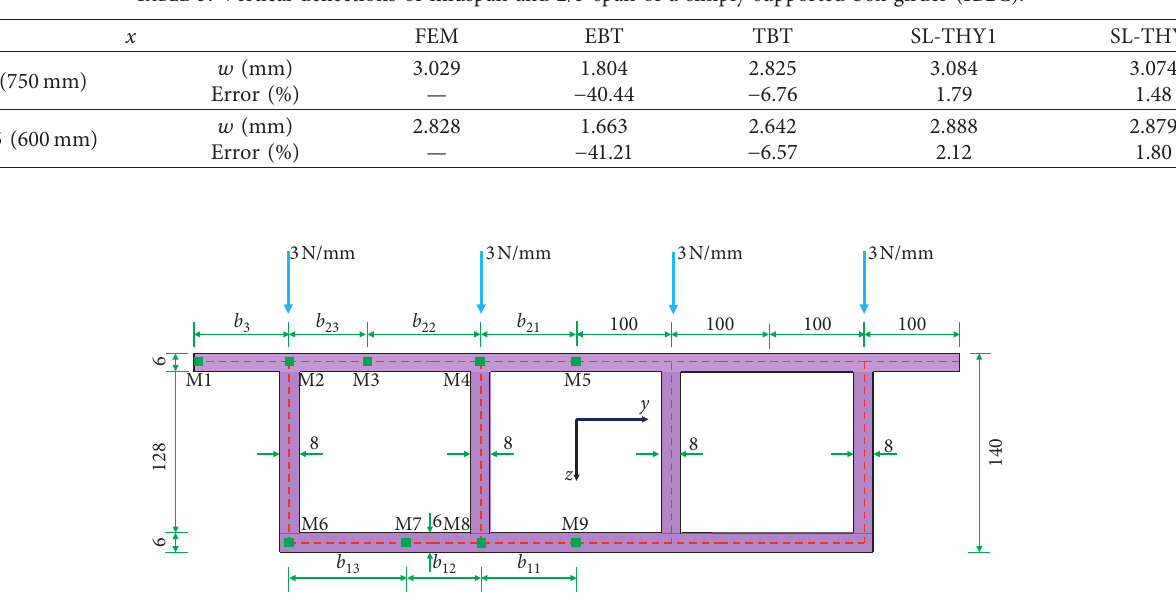
Figure 13: Cross section of the single-box three-cell box girder (unit: mm). Table 4: Parameters for shear lag effect analysis in the thin-walled single-box three-cell box girder. b 11 (mm)